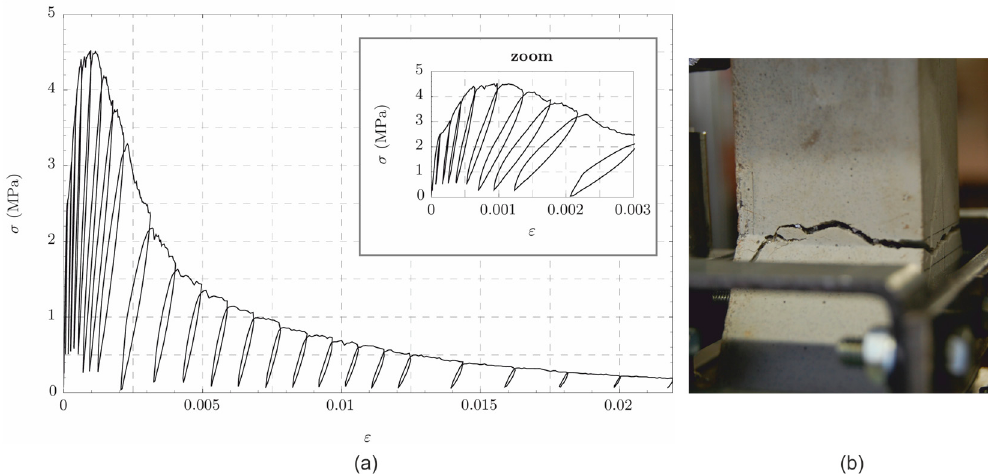
Figure 3. ( a ) Experimental stress–strain curve from tensile tests. ( b ) Picture of the cracked sample.